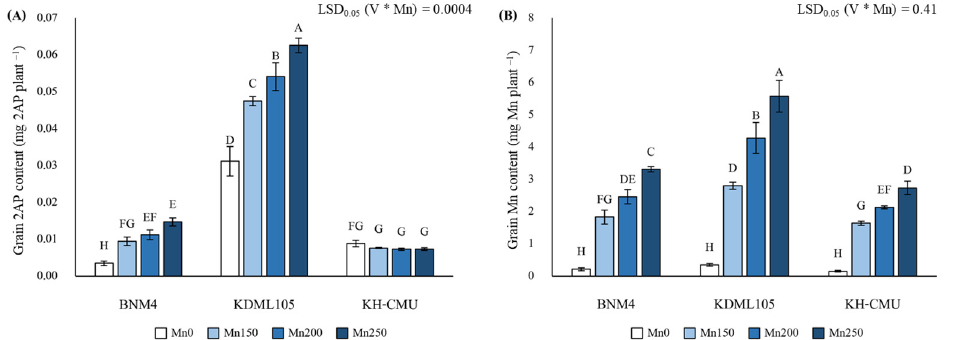
Figure 6. Effects of different manganese concentrations on the grain 2AP ( A ) and Mn ( B ) contents of different Thai fragrant rice varieties. Each column represents the mean of three data points ± standard errors ( n = 3). Means sharing a common letter do not differ significantly at p < 0.05.